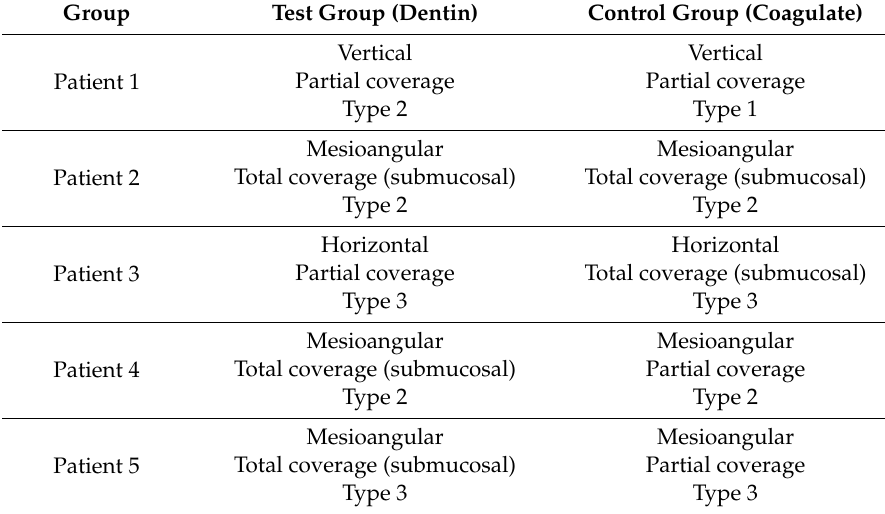
Table 2. Pre-operative and intra-operative characteristics in test and control